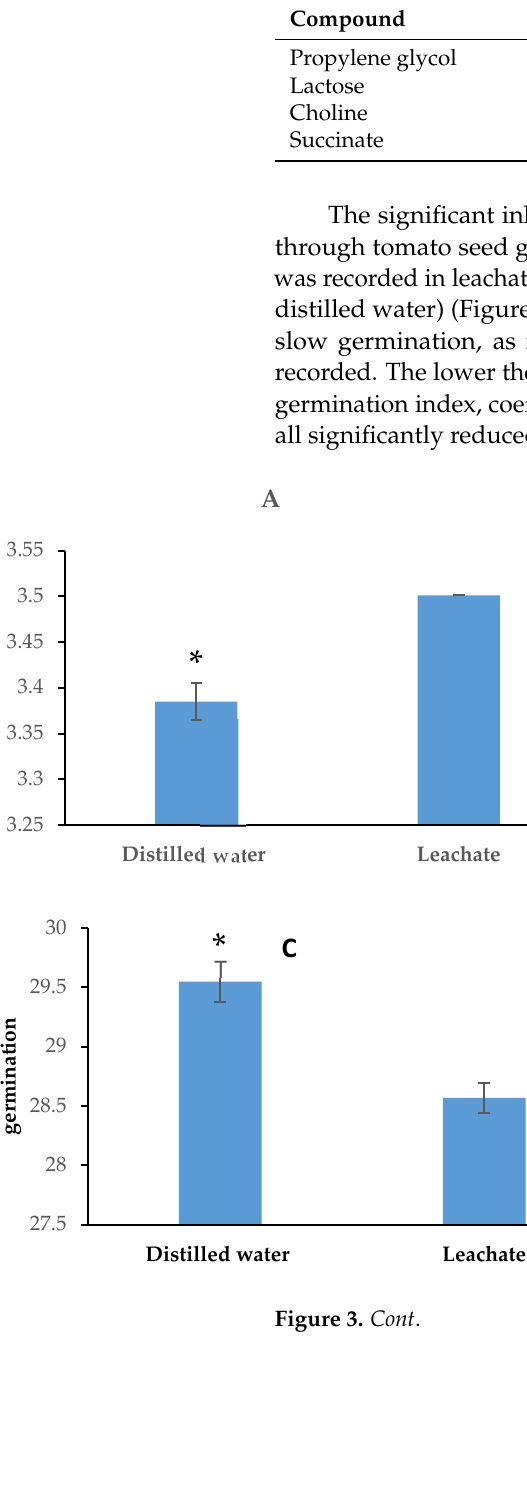
Figure 3. Effect of Hypoxis hemerocallidea leachate on tomato seed germination: mean germination time ( A ), germination index ( B ), coefficient of velocity of germination ( C ), germination rate index ( D ), and final germination percentage ( E ). *, ** = significant at p < 0.10 or p < 0.05, respectively. 3. Discussion Analysis of the leachate from H. hemerocallidea corms submerged in distilled water led to the identification of four main chemical compounds, namely, choline, succinate, propylene glycol, and lactose, each with the potential to inhibit bud growth and develop- ment [6,8,30]. Choline has growth-retarding effects on various plants and generally inhib- its the synthesis of GA 3 , renowned for its dormancy-breaking effects [31]. Chlorocholine- chloride (CCC) and acetylcholine, both having similar chemical structures to that of cho- line, have strong inhibitory effects on the growth of many plants, although their content is influenced by environmental conditions and plant developmental phases [6]. Choline was reported to be a neurotransmitter as a component of acetylcholine and its role is fa- cilitated by a set of enzymes and receptors linked to acetylcholine as a neuronal mediator